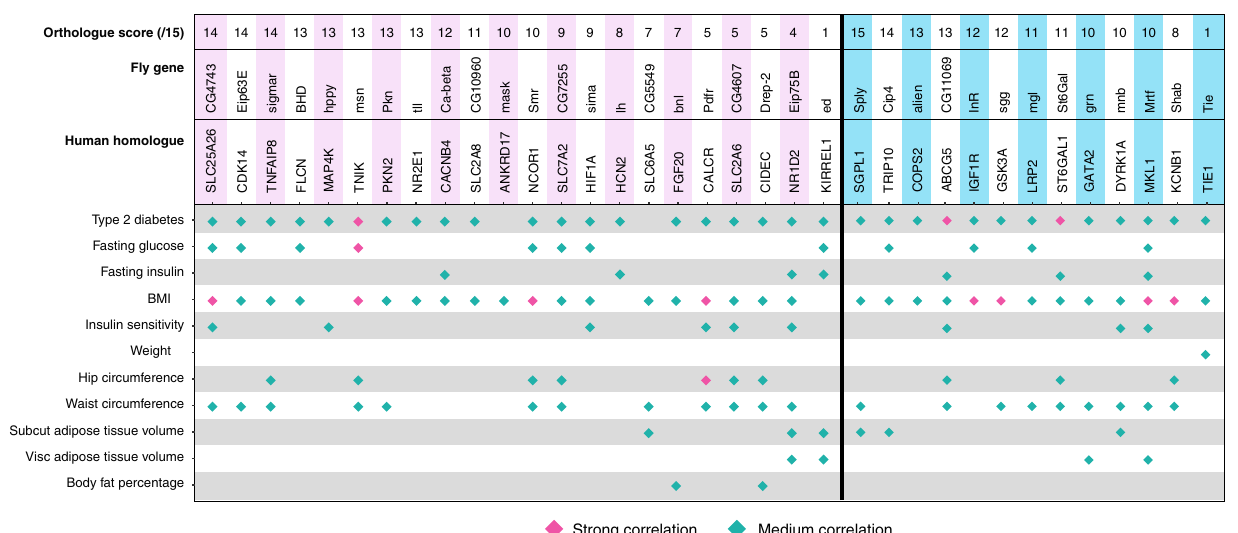
percentageVisc adipose tissue Body fat